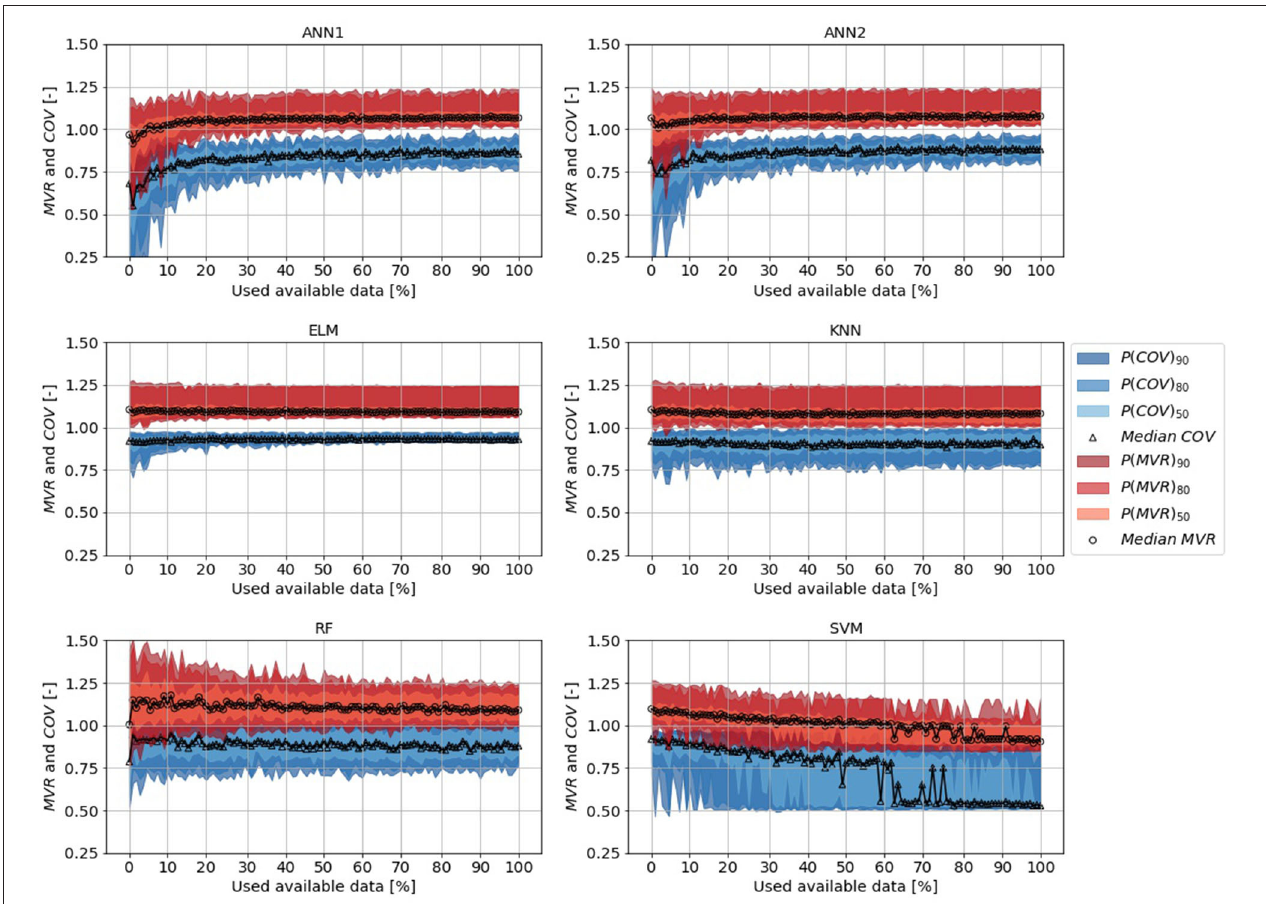
FIGURE 10 | Dependence of mean volume reproduction (MVR)/temporal coverage (COV) and size of the training data set for different ML-algorithms in trans-regional application. Uncertainty belts with different probabilities (50, 80, 90%) drawn for MVR in red scales, for COV in blue scales. The amount of training data has been raised incrementally to train the algorithms. Validation was performed on data sets in the Regen